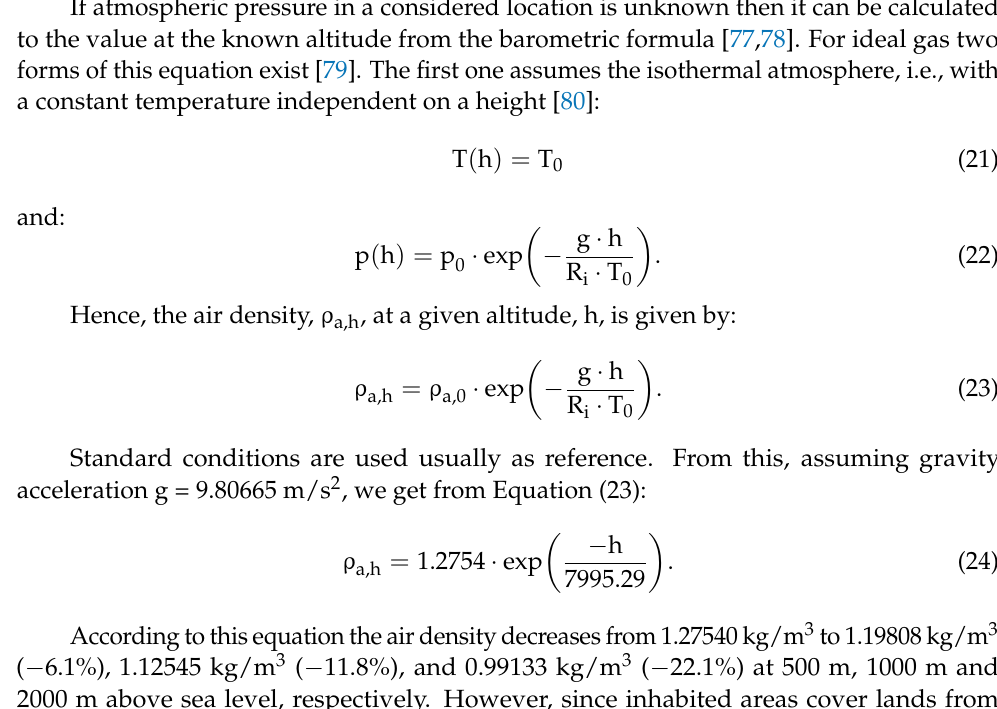
Figure 4. Dry air density variation as a function of its temperature and atmospheric pressure. Taking a pressure and temperature variation ranges from 950 hPa to 1050 hPa and from − 20 °C to +20 °C, respectively, the air density varies from 1.12896 kg/m 3 (950 hPa and +20 °C) to 1.44497 kg/m 3 at 1050 hPa and − 20 °C. In relation to 1.27540 kg/m 3 at 0 °C and 1000 hPa it means the corresponding change of − 13.0% and 13.3%.